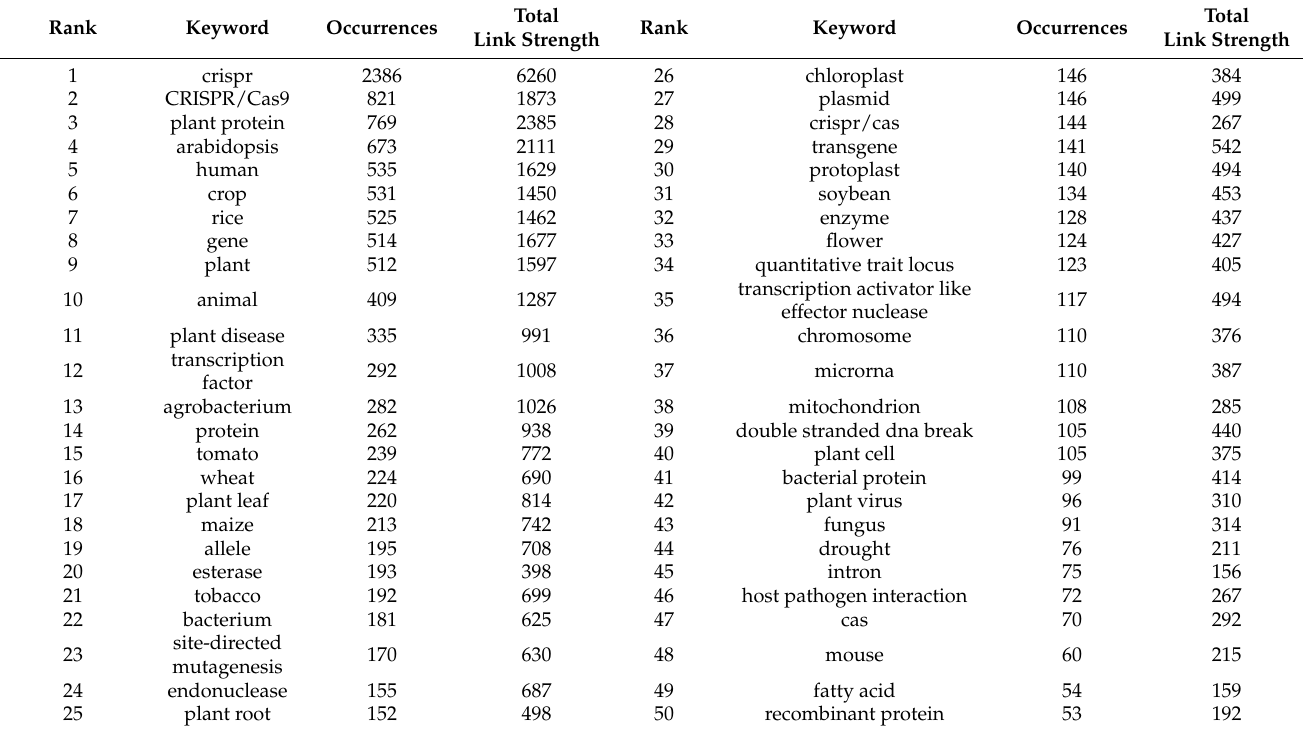
Table 2. A list of 50 most frequently occurring keywords in CRISPR-related plant research publications from 2012 to 2021. The ranking is based on the number of occurrences in the publications. Total link strength indicates the number of publications in which two keywords occur